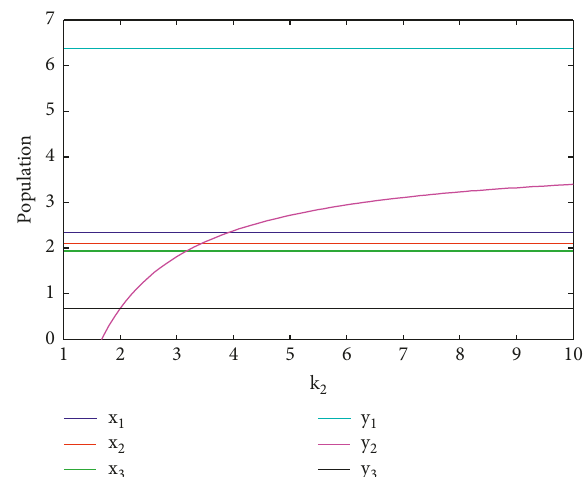
Figure 13: Variation of the system (1) with respect to k